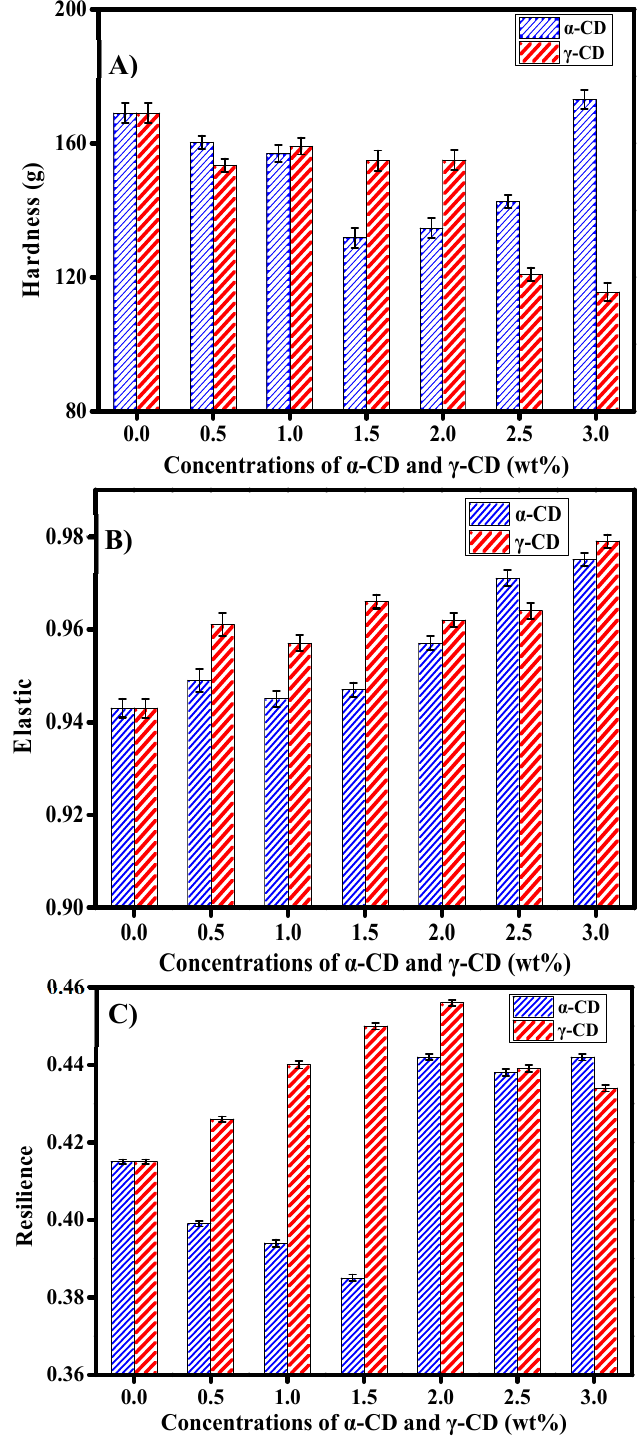
Figure 3. Effects of the addition of α -CD and γ -CD on the hardness ( A ), elasticity ( B ), and resilience ( C ) of frozen prebaked bread (frozen for three days). Bread samples were cut into 20 mm × 20 mm × 20 mm pieces and placed under the P / 100 probe. Samples were tested three times. The average of three measurements was calculated. Each group was tested six times in parallel.